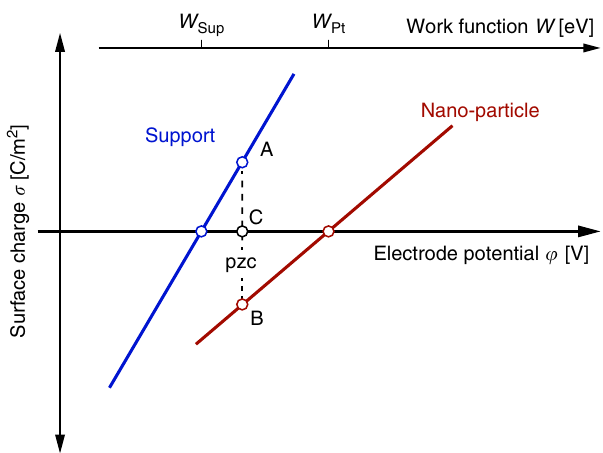
Fig. 1 Idealised sketch of the potential of zero charge of a heterogeneous electrode. Shown are linearised charging curves per total surface area for support and nano-particle as a function of potential; the overall pzc is de fi ned by equal but opposite charges on support (line AC) and nano- particle (line